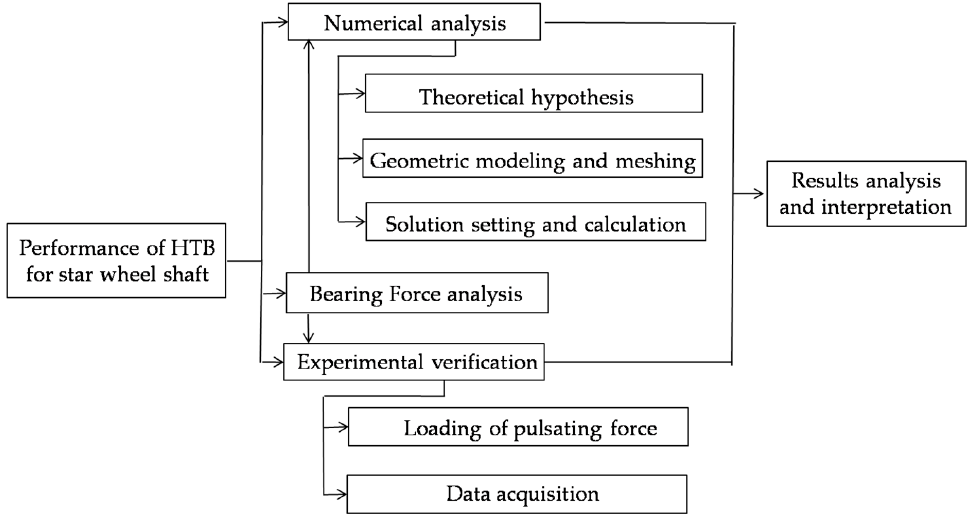
Figure 2. Structure of HTB: ( a ) HTB with crossing groove; ( b ) HTB with annular groove.